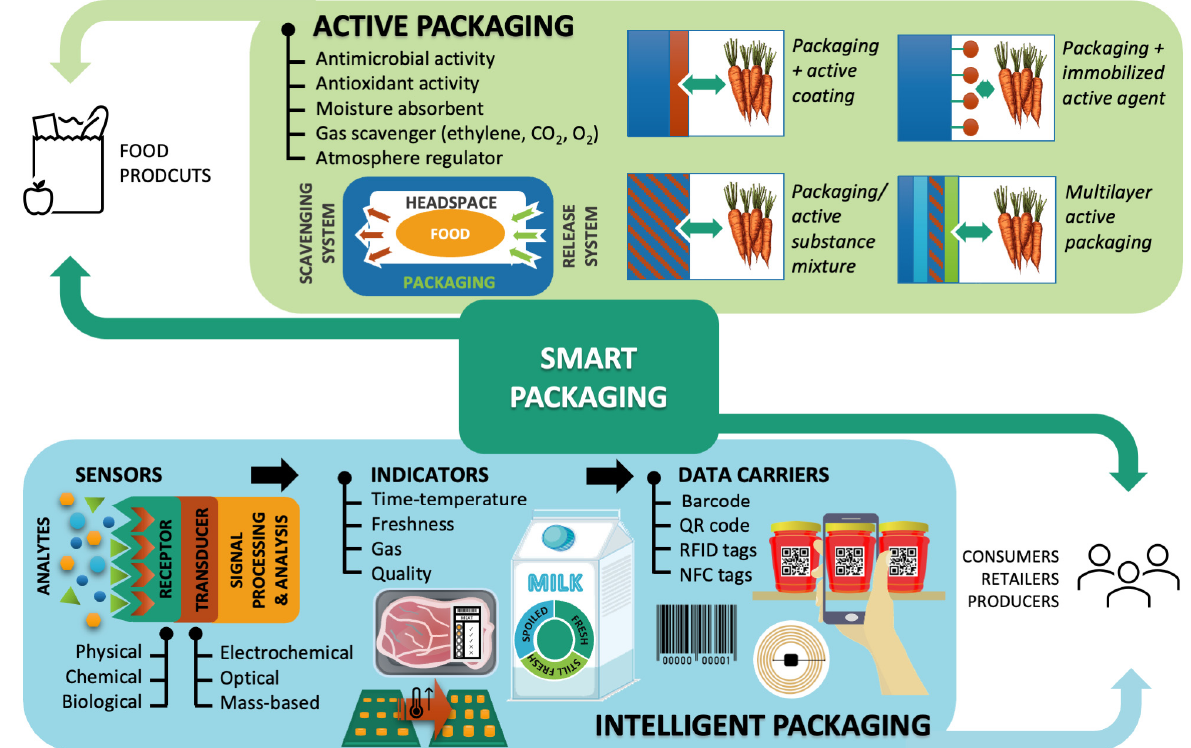
Figure 3. Classification of active, intelligent, and smart packaging, considering main properties, applications, interactions, and some examples.